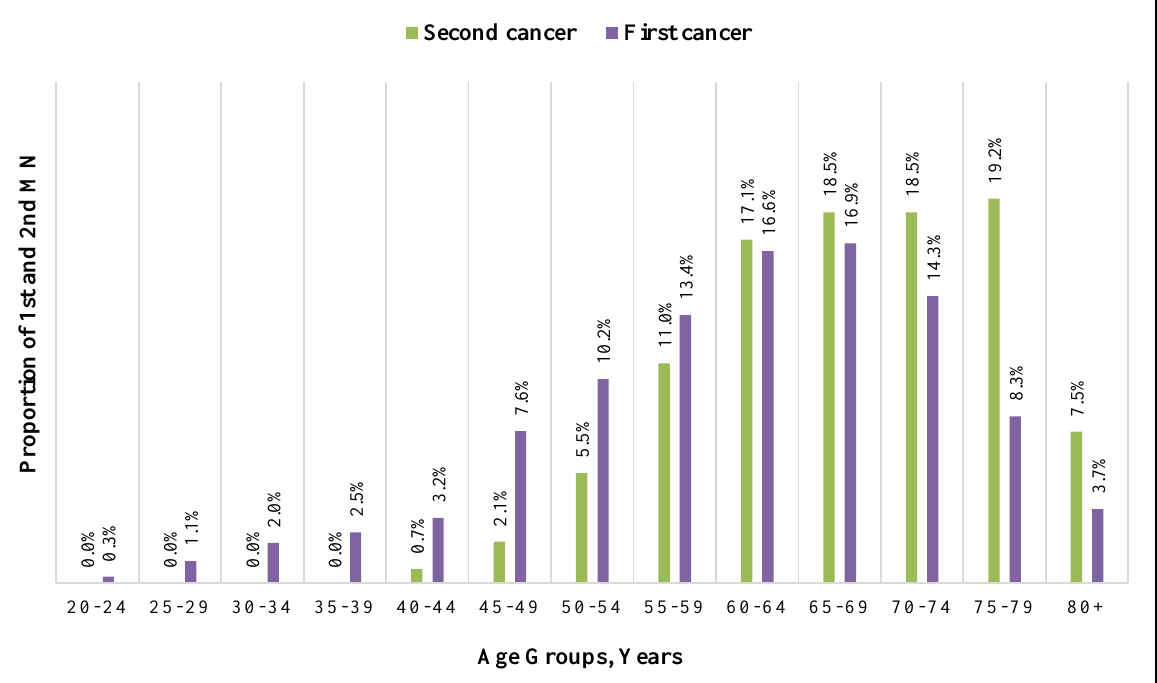
Figure 2. The distribution of 1 st and 2 nd MN by age attained (excluding NMSC)